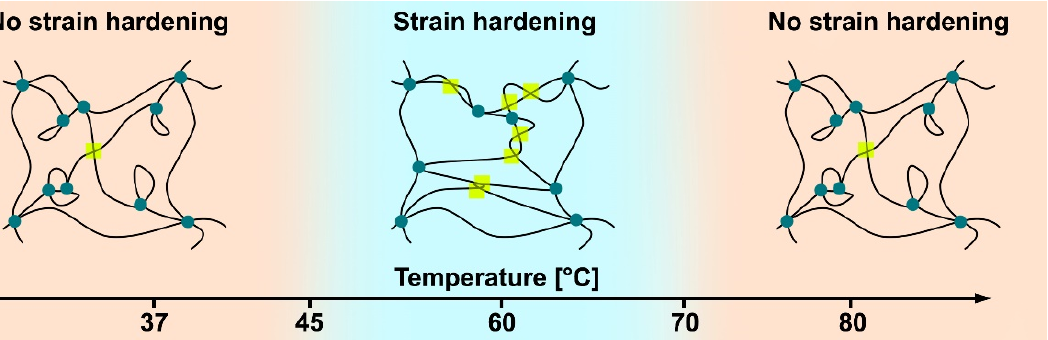
Scheme 1. Proposed mechanism for the effect of temperature on strain hardening of highly acety-